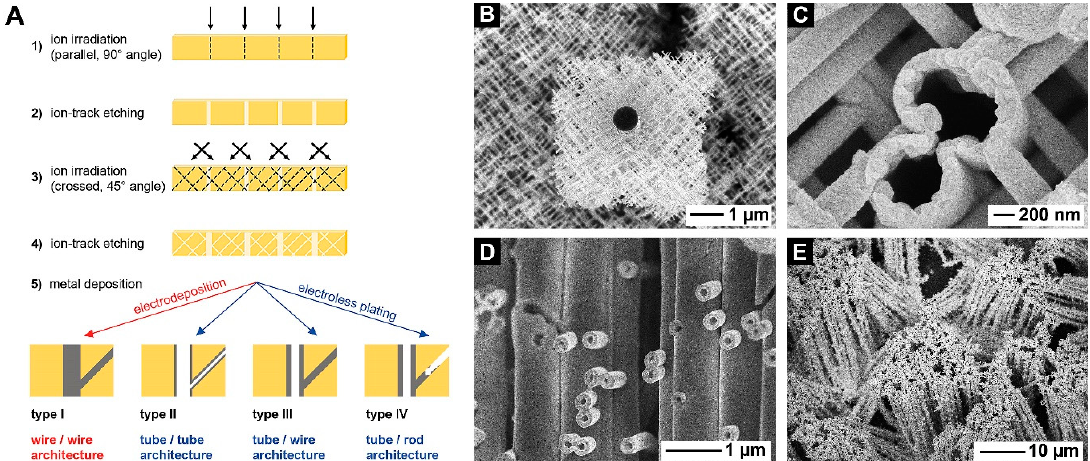
Figure 9. ( A ) Categorization of different nanostructures deposited in ion-track etched polymer templates of bimodal pore size. ( B ) Electrodeposited 3D Pt micro-/nanowire network. ( C ) Electrolessly plated Ag nanotube-nanowire network. ( D ) Electrolessly plated, hierarchical Cu nanotube-nanotube network. ( E ) Au nanorod-on-nanotube array, which shows aggregation due to the missing interconnection. Reprinted (adapted) with permission from [90]. Copyright (2016) Elsevier B.V.